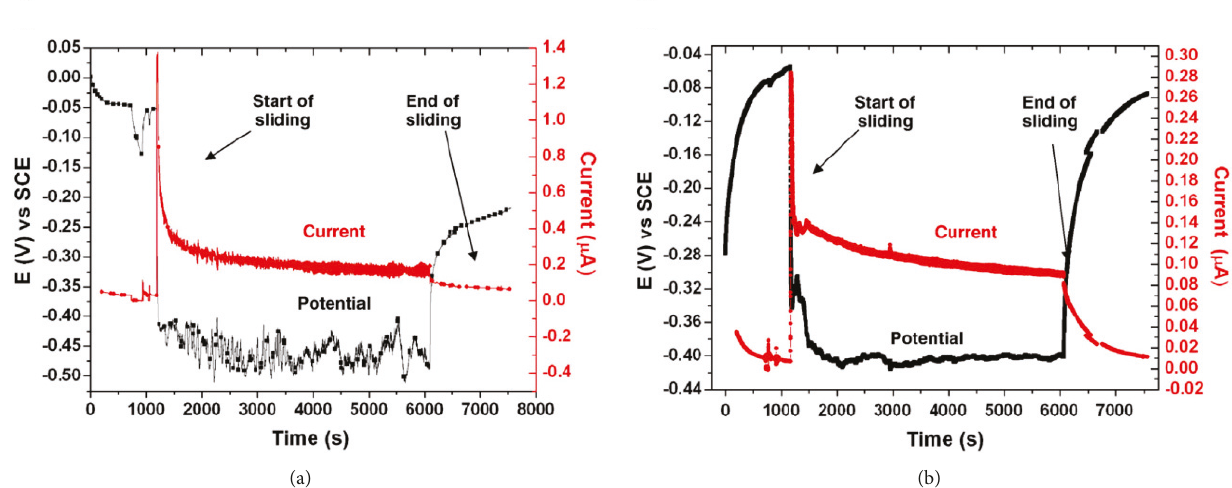
Figure 12: Potential and current response measured by electrochemical noise technique on (a) AISI 304 stainless steel and (b) duplex treated 304 against corundum in HBSS. In both cases, the potential decreases and the current increases during sliding, as a consequence of removing the passive layer and exposing the bare material to electrolyte